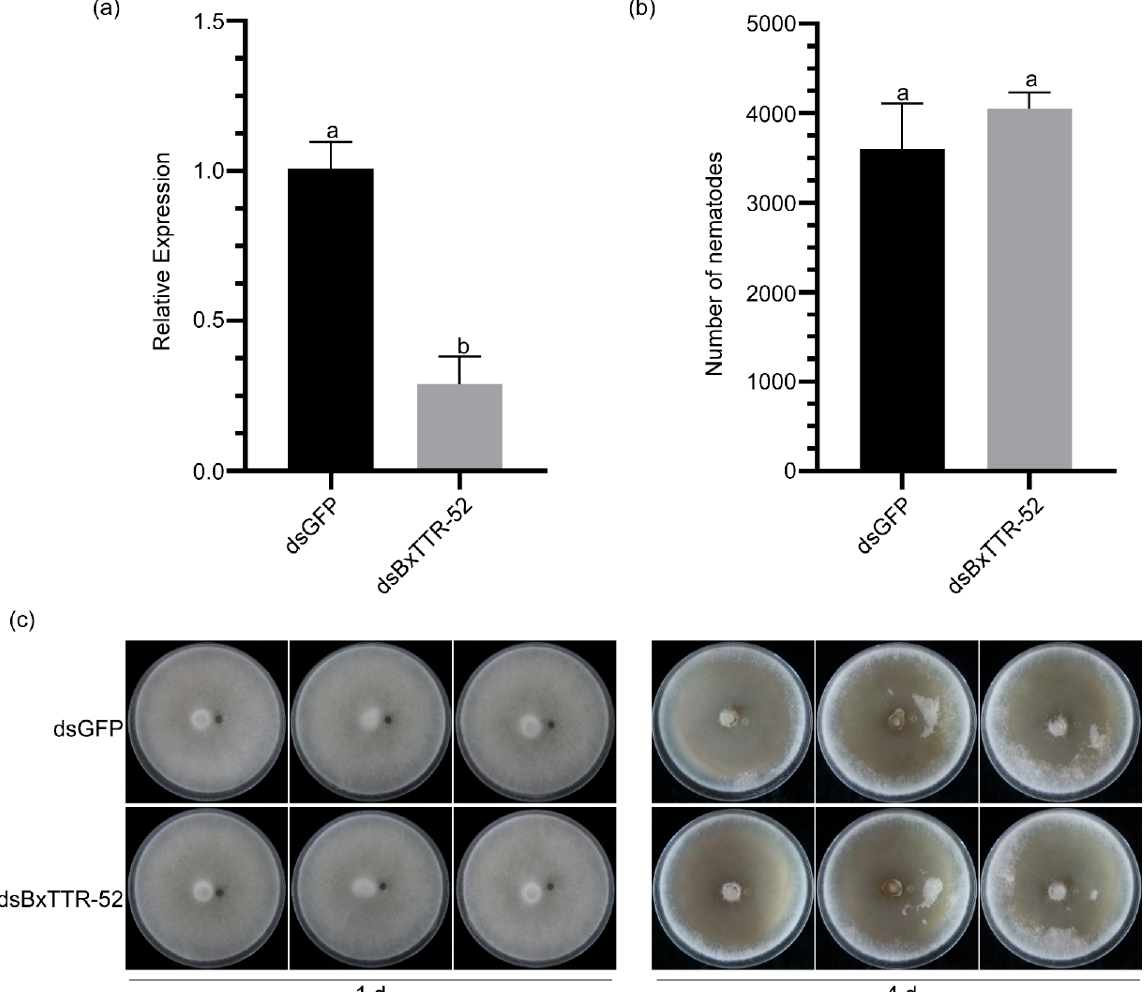
Figure 4. The effect of BxTTR-52 silencing on the reproduction and feeding rate of Bursaphelenchus xylophilu s. ( a ) The silencing efficiency of BxTTR-52 in B. xylophilus . ( b ) The number of nematodes on Botrytis cinerea over 4 days. ( c ) The propagating quantity of B. xylophilus cultured on B. cinerea . Values represent the means ± SD of three independent biological samples. Different letters on top of the bars indicate statistically significant differences ( p < 0.05, t -test) as measured by Duncan’s multiple range